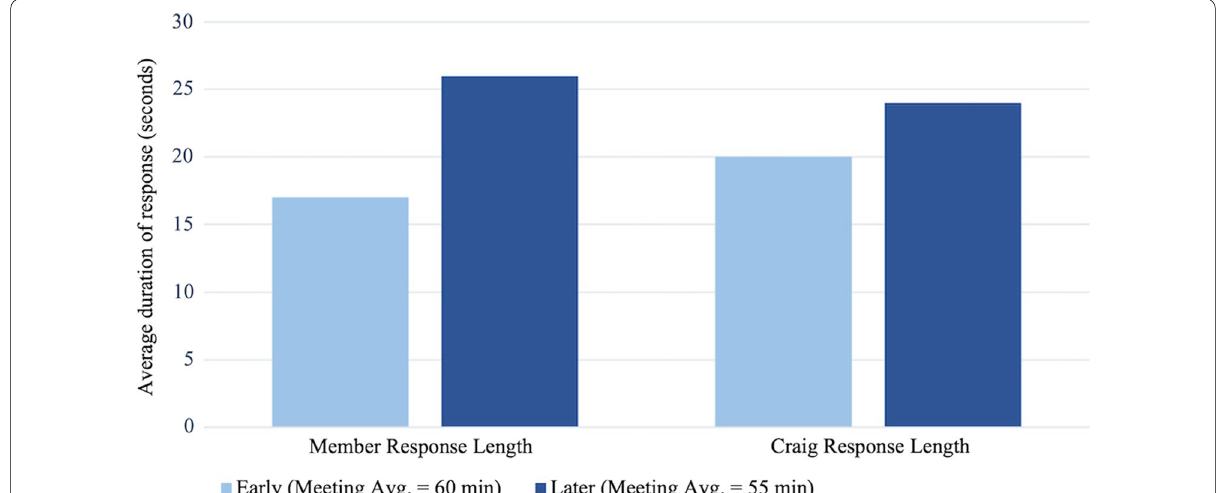
Fig. 7 Average length of the responses of Craig and of members during early and later group meetings. Response duration is indicated in the average length (in seconds) of individual responses. Co-facilitator talk is not represented on this